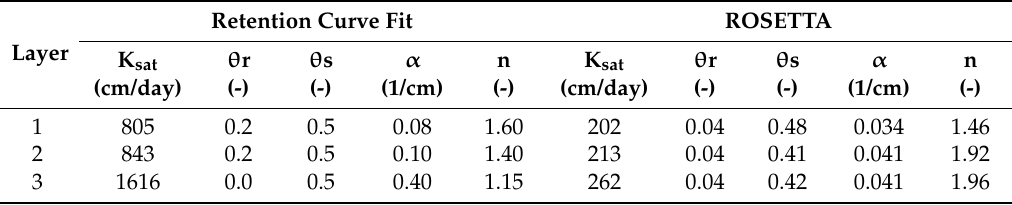
Table 1. Estimation of hydrodynamic parameters obtained through fitting the hydraulic retention curves and ROSETTA pedotransfer function. The K sat value of the first parameter set was obtained using the constant head permeability